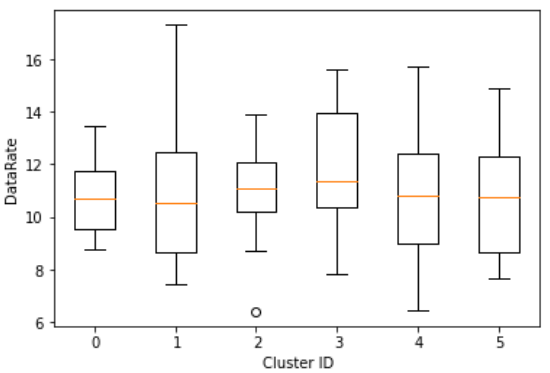
Figure 7. Comparison of the data rate among the clusters when | N | = 100.